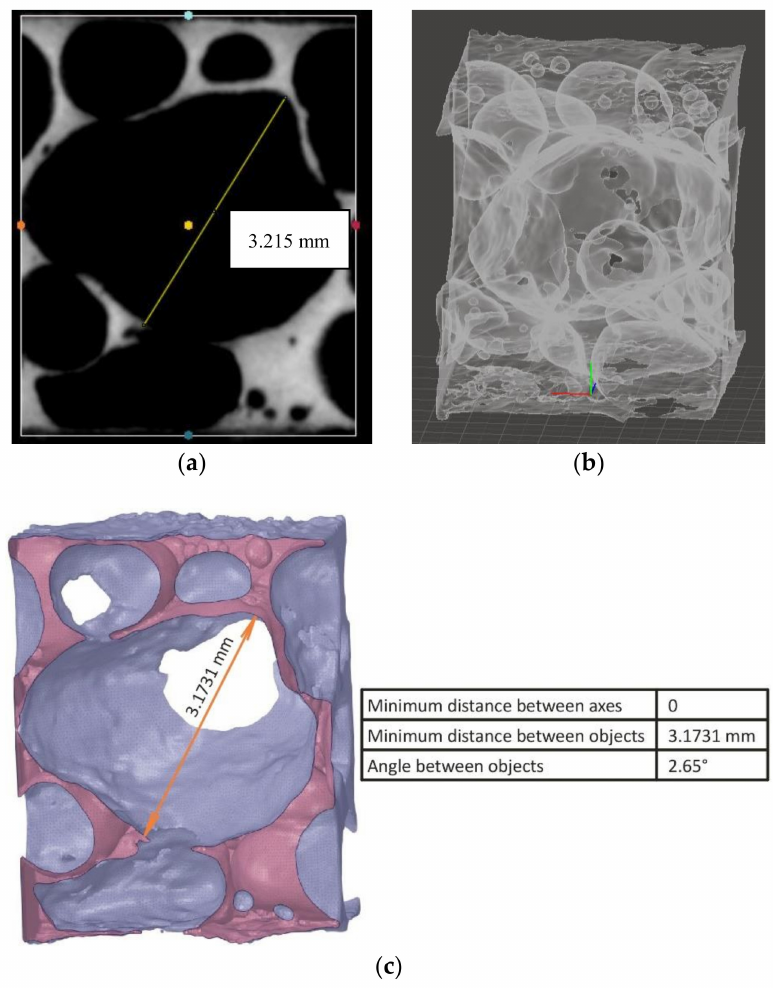
Figure 7. ( a ) Pore wall distance of 3.215 mm measured at ImageJ software of the sagittal image view of the midsection slice image, ( b ) pore distribution, and ( c ) pore wall distance of 3.1731 mm measured at the midsection of the 3D model in SpaceClaim module of Ansys